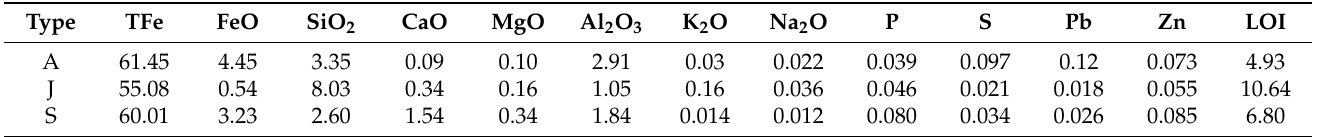
Table 1. Chemical compositions of three iron lump ores.